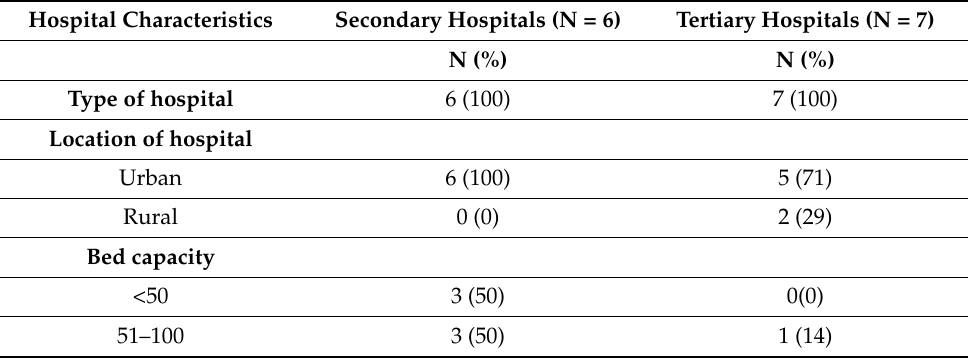
Table 2. Characteristics of the 13 hospitals in the Western Area of Sierra Leone assessed on hand hygiene policy using the HHSAF in